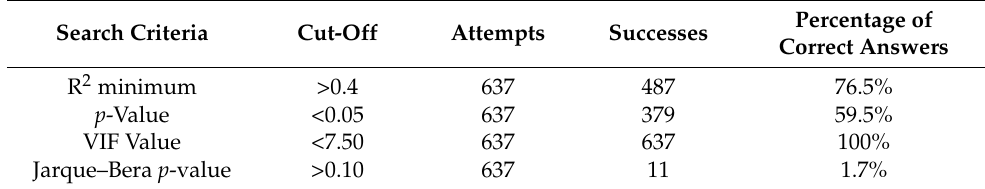
Table 1. Percentage of accepted regressions according to search criteria.